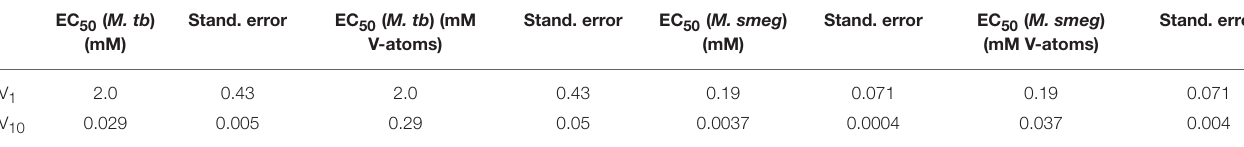
TABLE 2 | The EC 50 values for V 1 and V 10 treated Mycobacterium tuberculosis and smegmatis . EC 50 ( M. tb ) Stand. error EC 50 ( M. tb ) (mM Stand. error EC 50 ( M. smeg ) Stand. error EC 50 ( M. smeg ) Stand. (mM) V-atoms) (mM) (mM V-atoms)